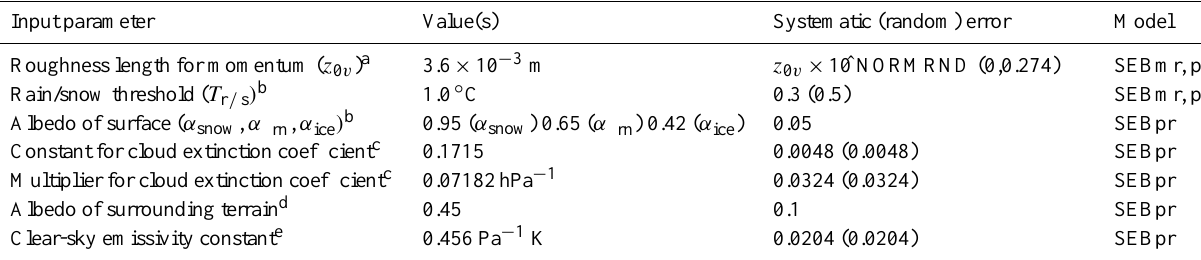
Table 3. Input parameter uncertainty introduced in Monte Carlo simulations of SMB